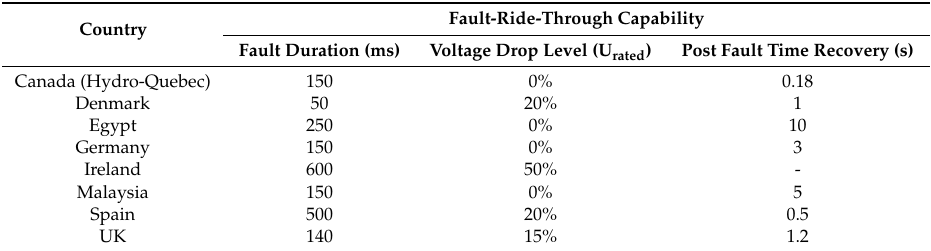
Table 2. FRT capability requirements for PVDG according to different national grid codes [33,42,43].